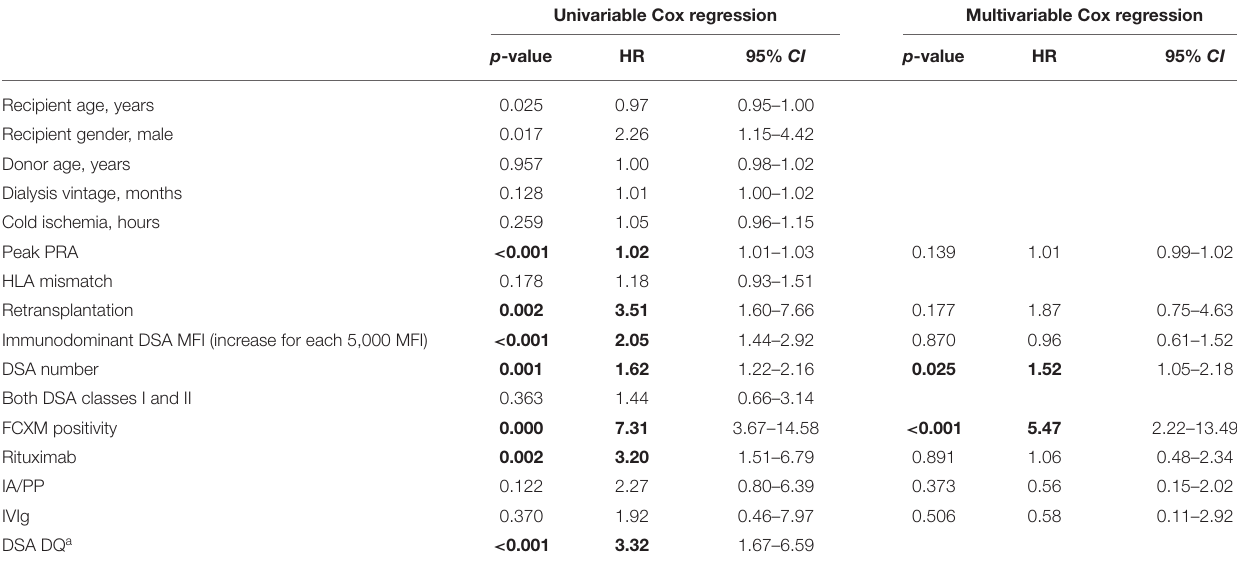
TABLE 4 | Risk factors of antibody-mediated rejection (ABMR) occurrence in donor-specific antibody plus patients in univariable and multivariable Cox regression model.